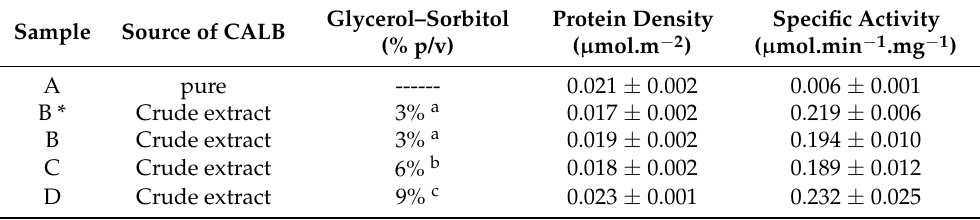
Table 3. Source of CALB lipase, protein density, percentage of polyols (glycerol and sorbitol) and specific activity in the enantiomeric esterification of rac -ibuprofen with ethanol in isooctane at 45 ◦ C for 12